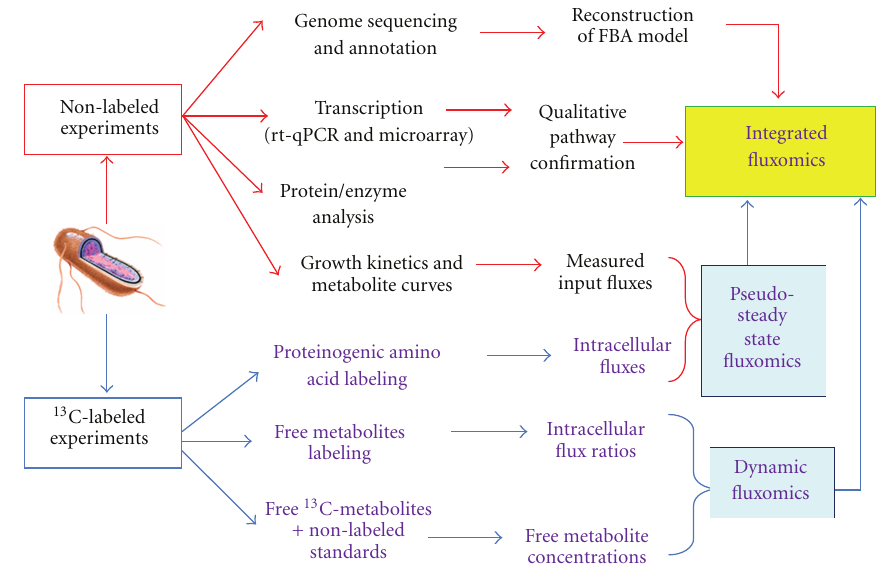
Figure 2: 13 C-assisted cellular metabolism